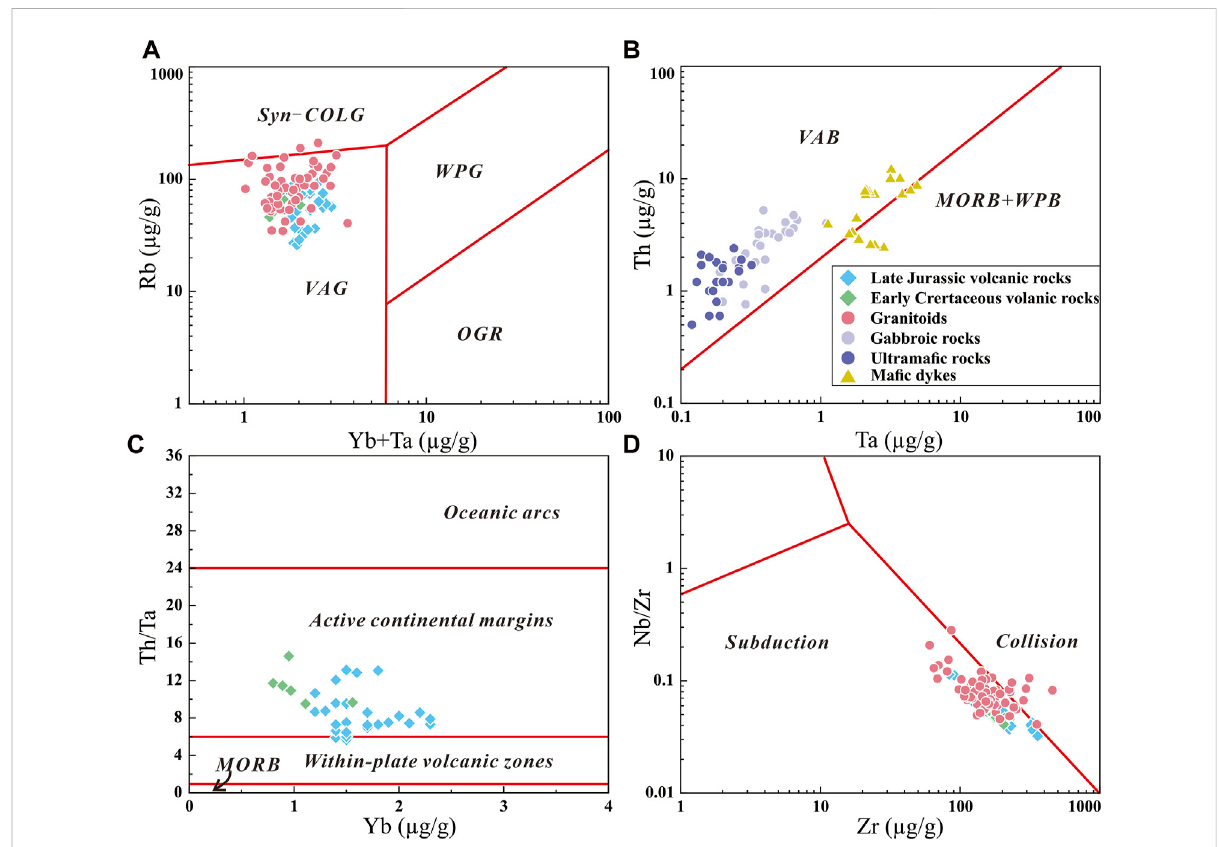
FIGURE 9 Tectonic discriminative diagrams for magmatic rocks from the Laiyuan complex. (A) Rb vs Yb+Ta diagram (Pearce, 1984). (B) Th vs Ta diagram (Pearce and Peate, 1995). (C) Th/Ta vs Yb diagram (Pearce and Peate, 1995). (D) Nb/Zr vs Zr diagram (Tarney and Jones, 1994). Data source are same as in Figure